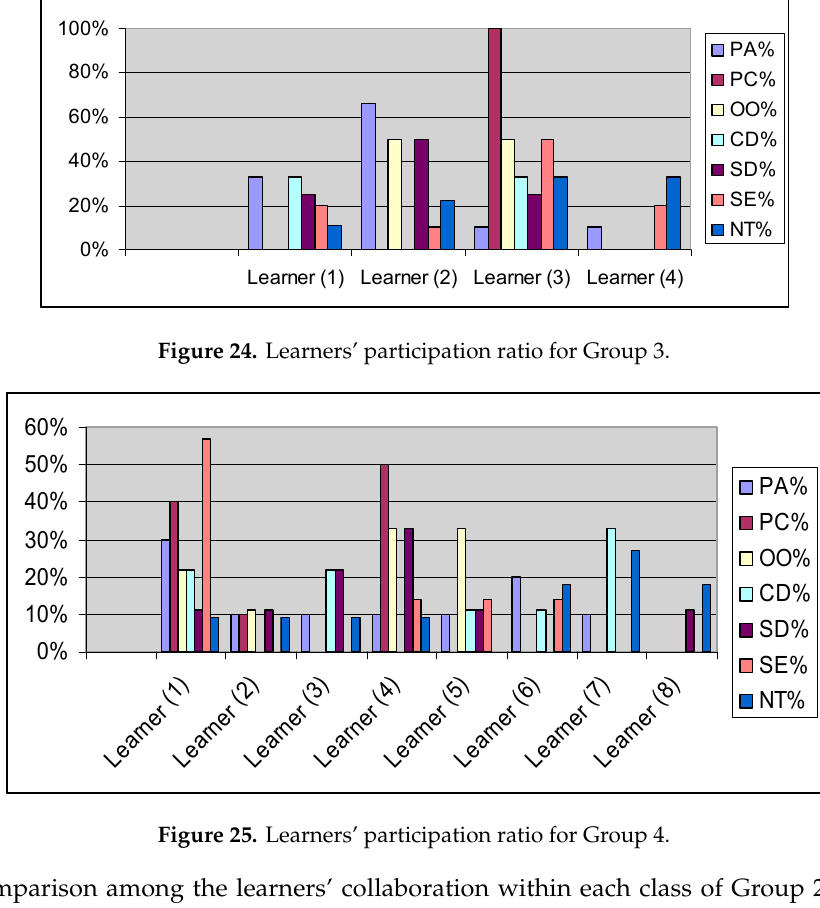
Figure 26. Member quality of collaboration assessment.